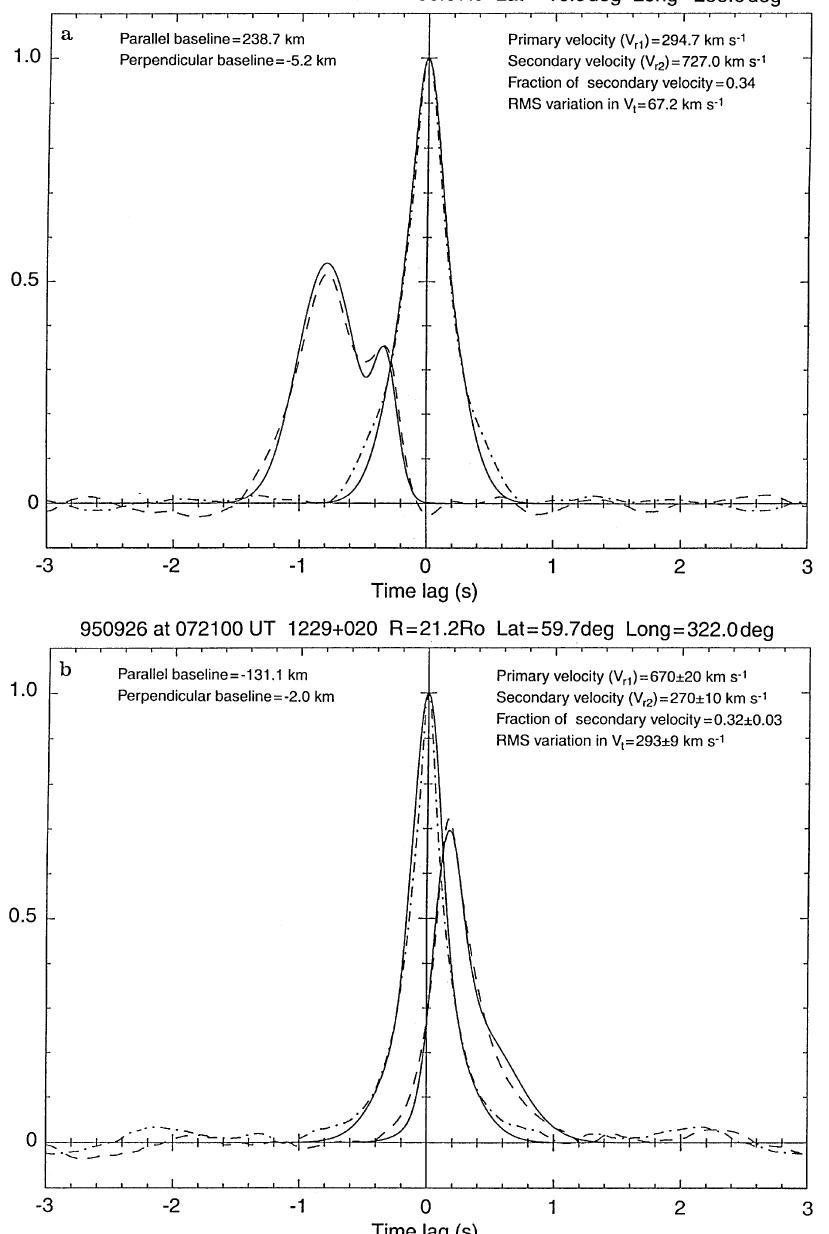
Fig. 3. a Observations of 0318 # 164 on 2 May 1994, showing a two-peak correla- tion function analysed using the two- velocity model. The dashed line represents the data and the solid line the model fit; b Observations of 1229 # 020 on 26 Sep- tember 1995, showing a skewed single peak correlation function analysed using the two-velocity model. The dashed line repre- sents the data and the solid line the model